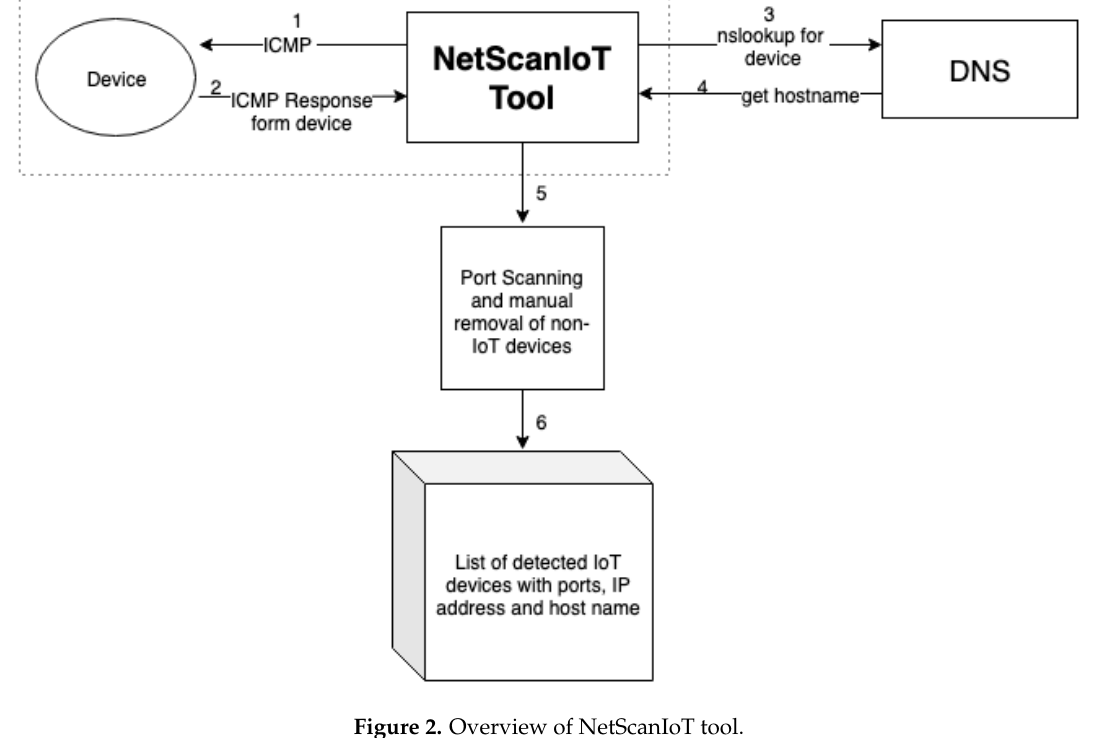
Figure 2. Overview of NetScanIoT